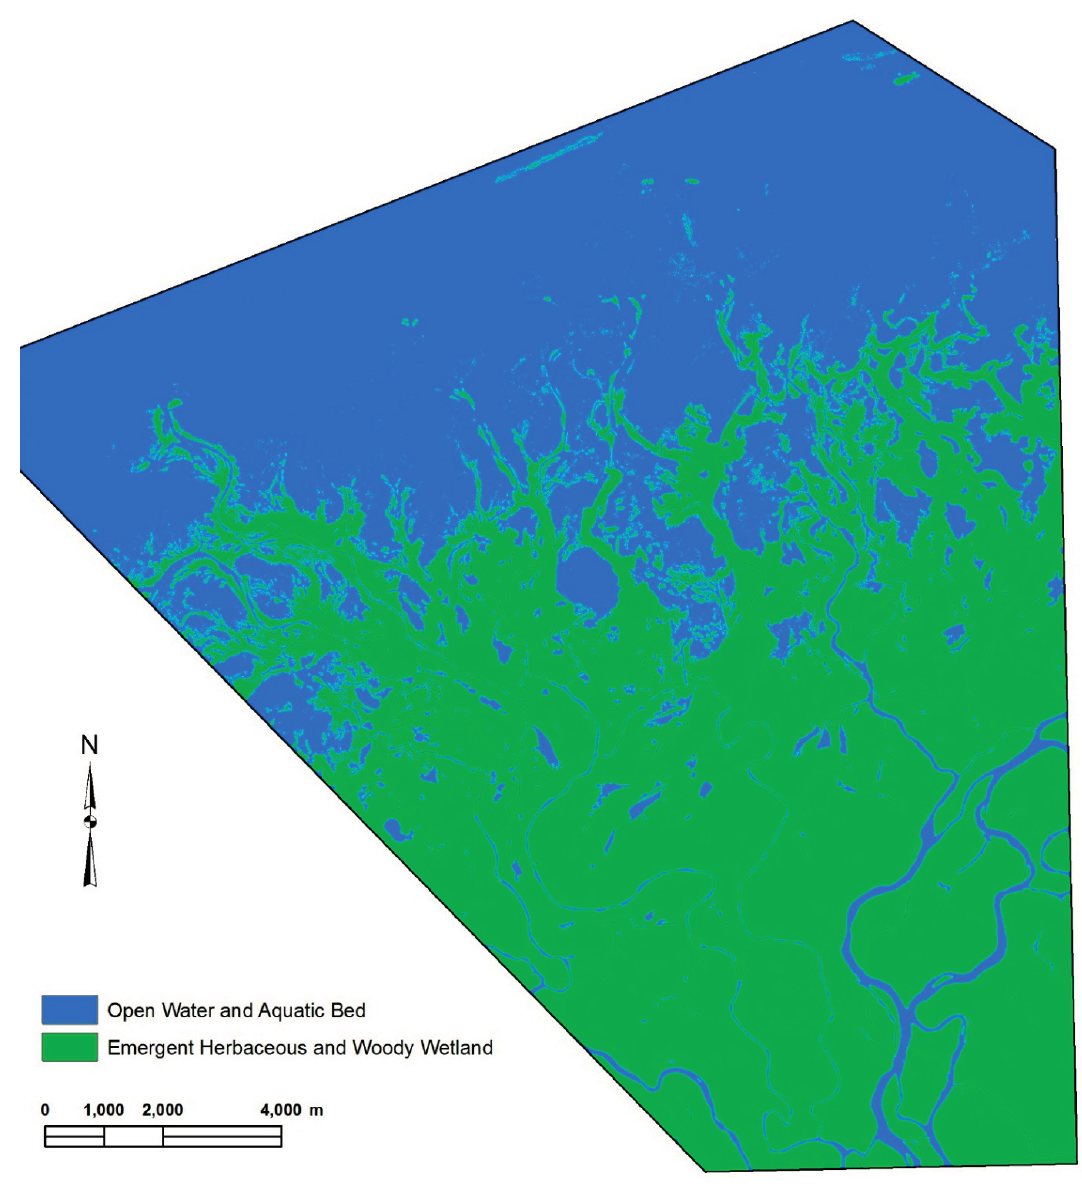
Figure A1. Coarse-scale binary classification of the Selenga River